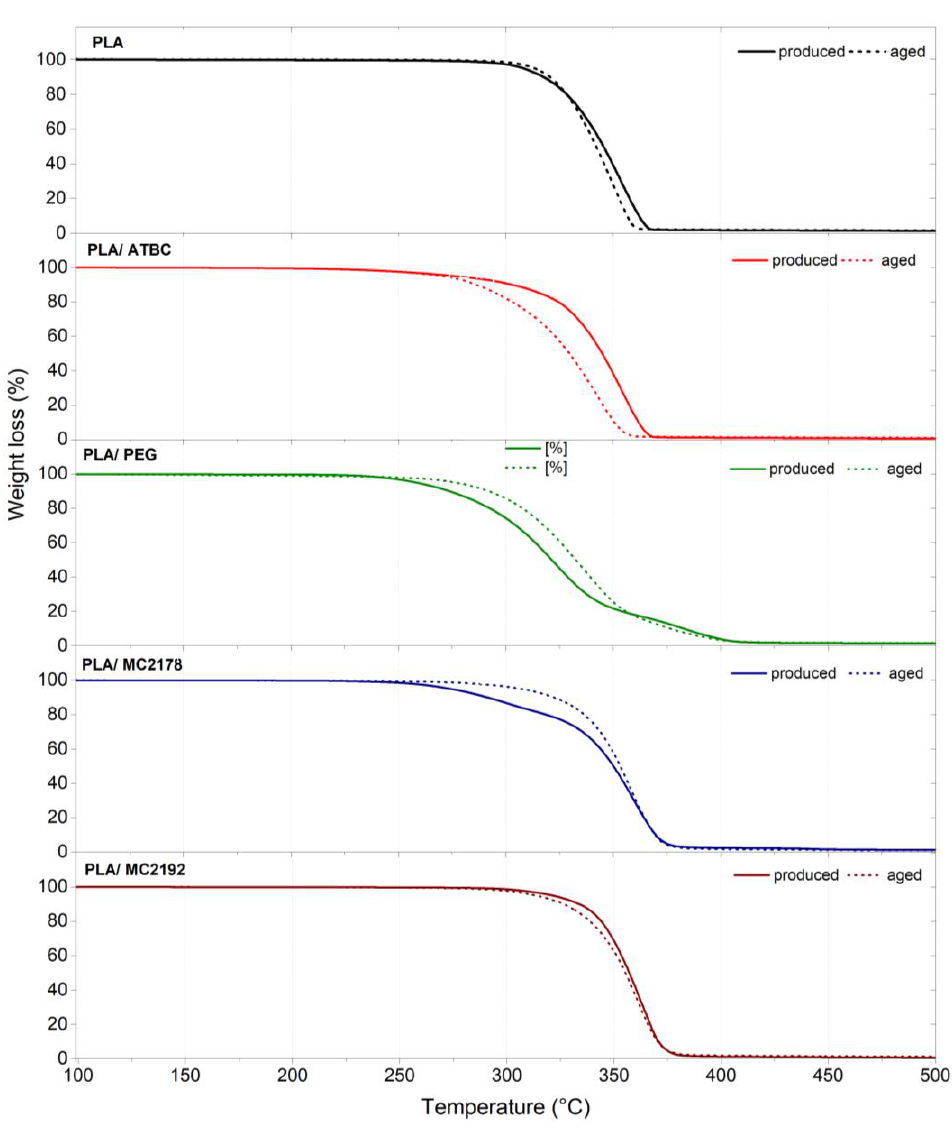
Figure 5. TGA curves of neat and plasticized PLA films after production and accelerated ageing. Table 5. TGA data of neat and plasticized PLA films after production, accelerated ageing, and composting